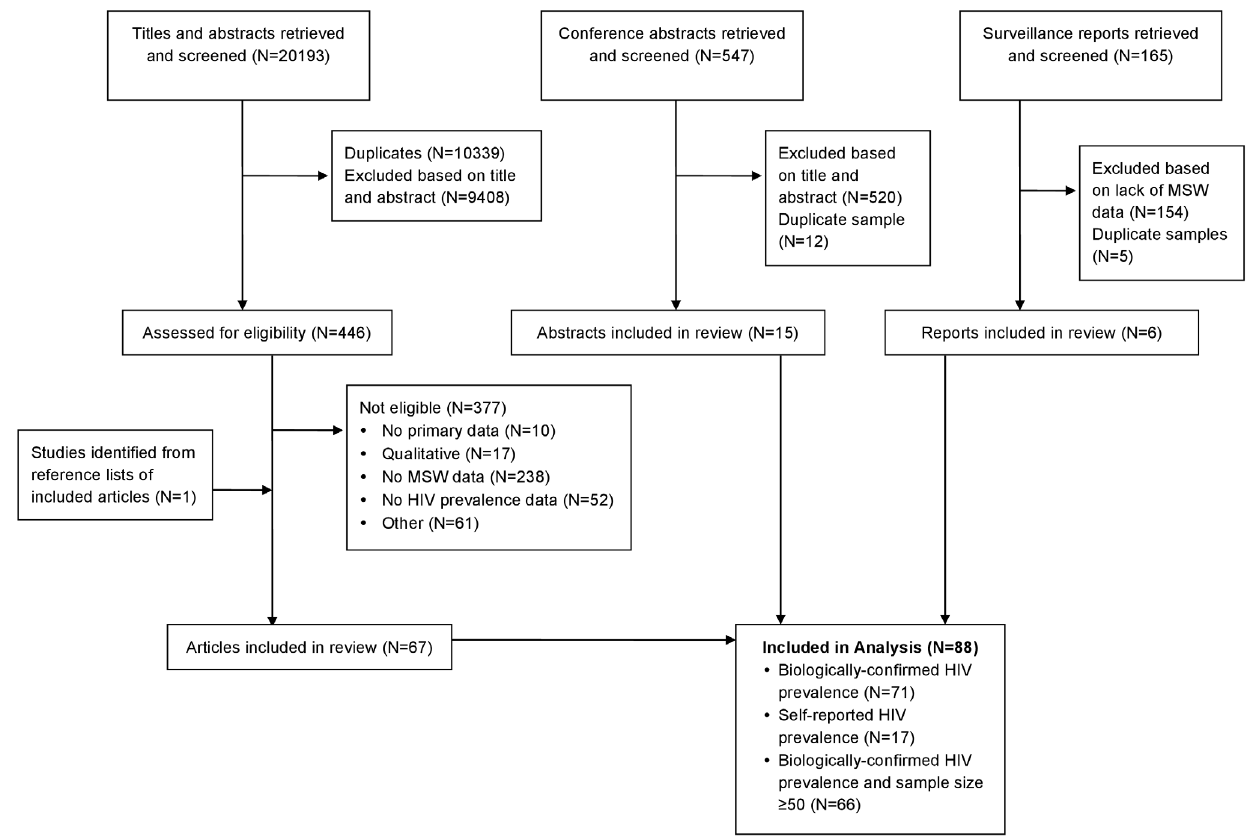
Figure 1. Flow diagram of included studies.